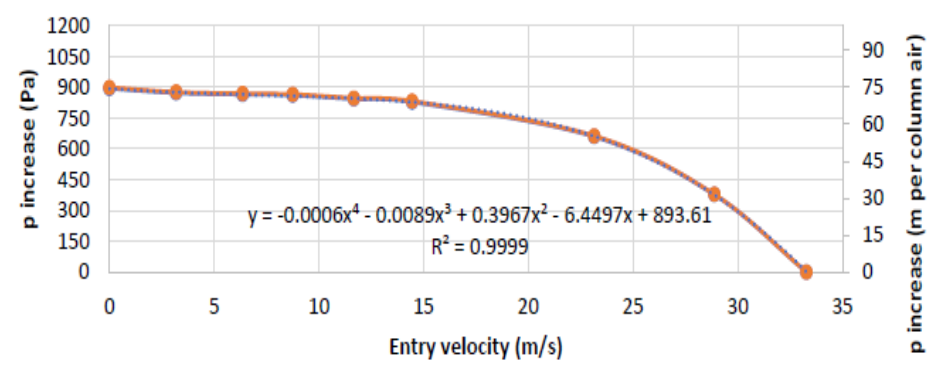
Figure 2. Pressure increase as function of the inlet velocity at real operating